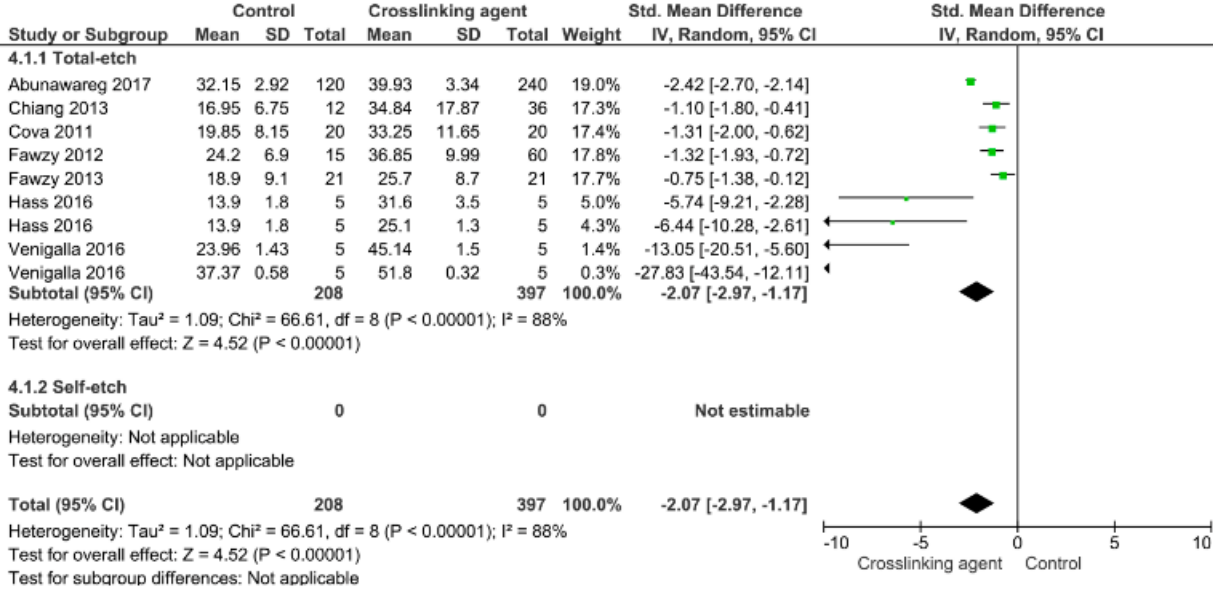
Figure 7. Forest plot of the immediate ( A ) and long-term ( B ) bond strength comparison between the riboflavin crosslinking agent and the control according to the adhesive used [17,83,102,106,114,116– 118].